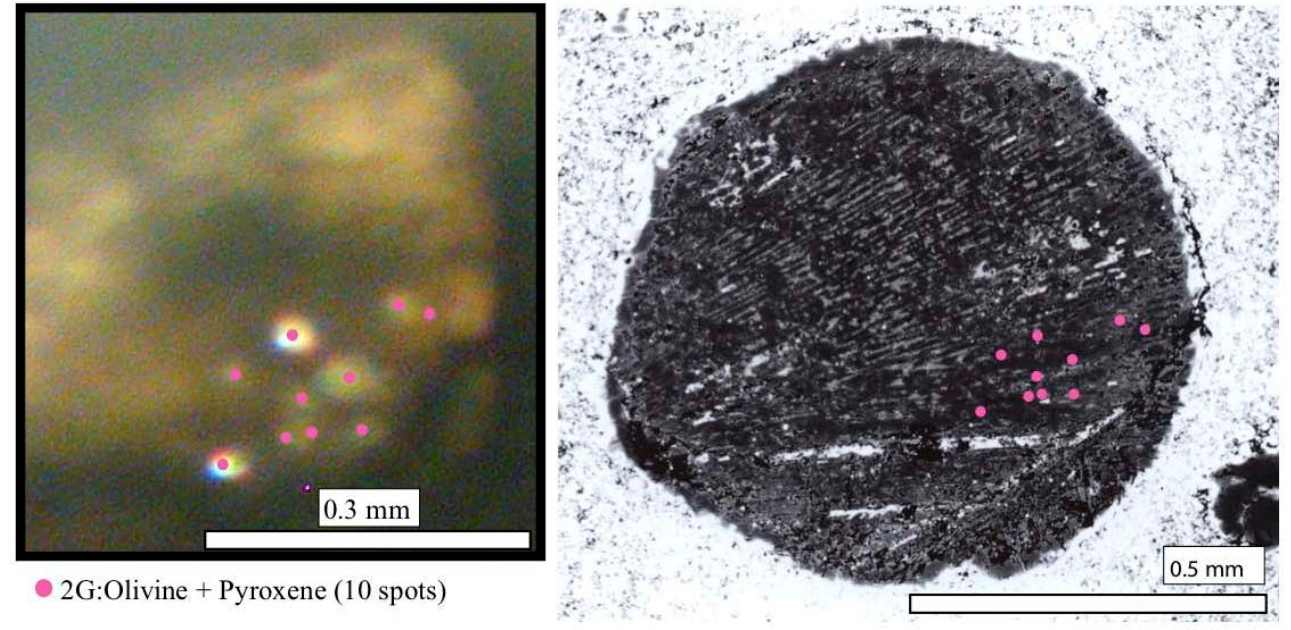
Figure 5. Optical view and BSE image of BOC-07 showing laser shot locations. The number of laser spots is ten shots for the 2G olivine + pyroxene phase (pink).